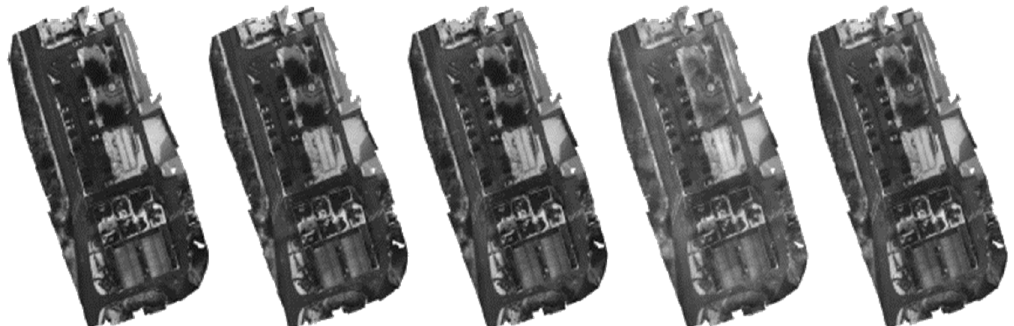
Figure 7. Five bands orthomosaic images of the multispectral camera for the first test site.